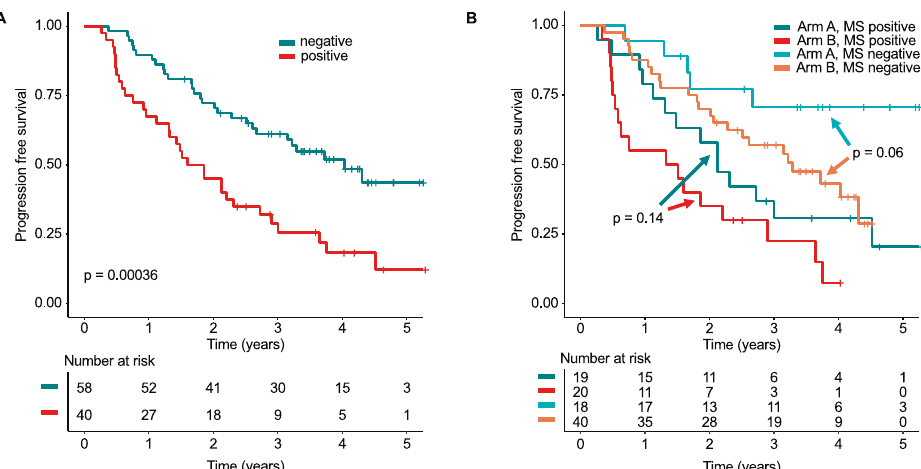
Fig. 4 Prognostic Impact of mass spectrometry in patients with complete response. A PFS landmark analysis of patients in CR from the start of maintenance therapy/observation strati fi ed by mass spectrometry (MS). In ( B ) patients in CR were strati fi ed by the combination of MS and the GMMG-MM5 treatment arm (arm A lenalidomide maintenance for a maximum of 2 years, arm B observation only, if CR). Blood Cancer Journal (2023)